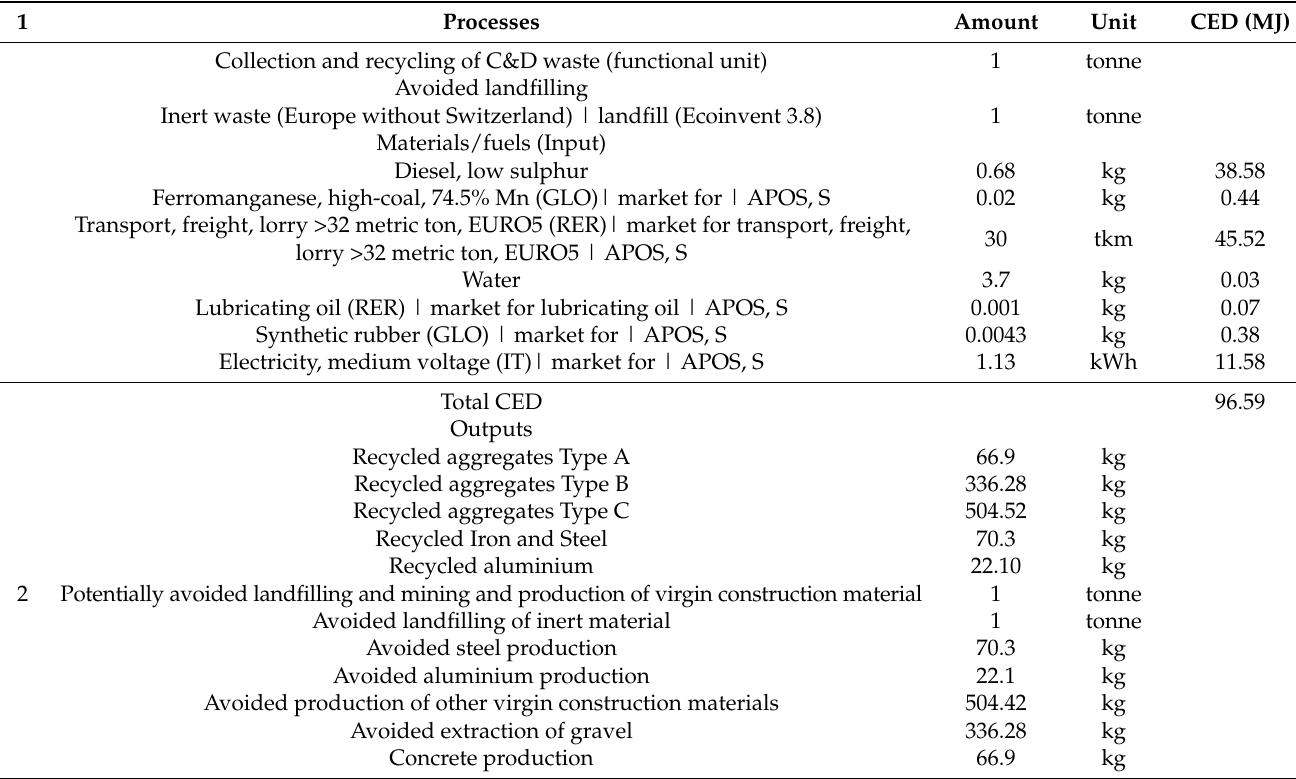
Table 1. Inventory data for 1 tonne of C&DW collected and recycled in the Metropolitan City of Naples. 1 Processes Collection and recycling of C&D waste (functional unit) Avoided